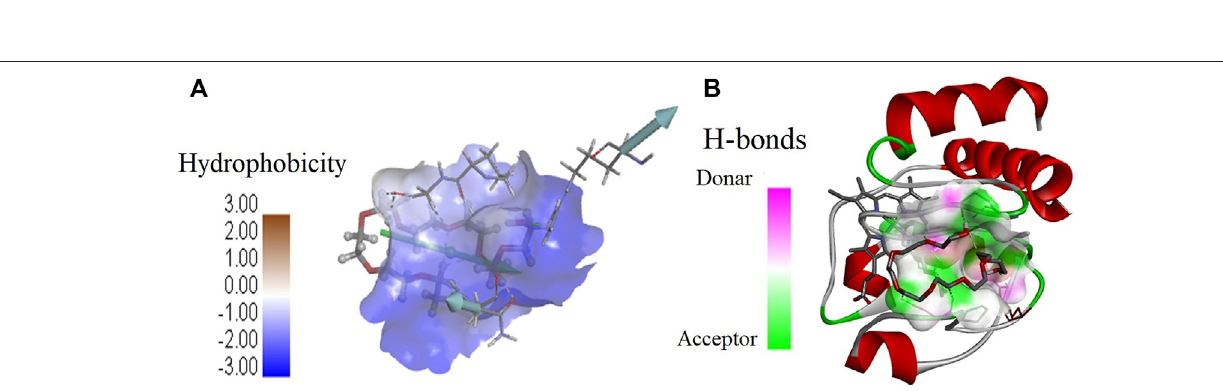
Frontiers in Molecular Biosciences |